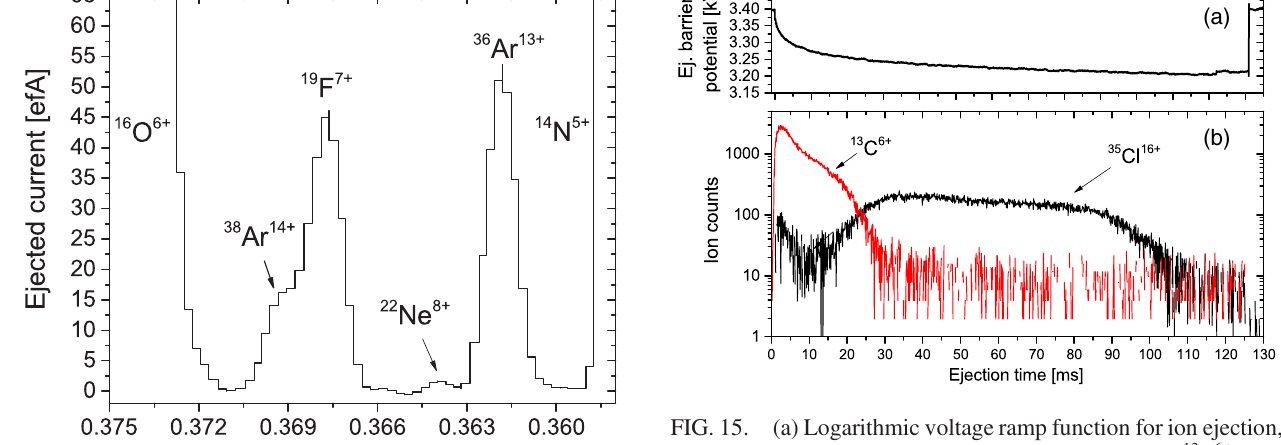
FIG. 15. (a) Logarithmic voltage ramp function for ion ejection, and (b) stretched ion time distribution of ejected 13 C 6 þ and 35 Cl 16 þ measured after the Q=A separator with an MCP.